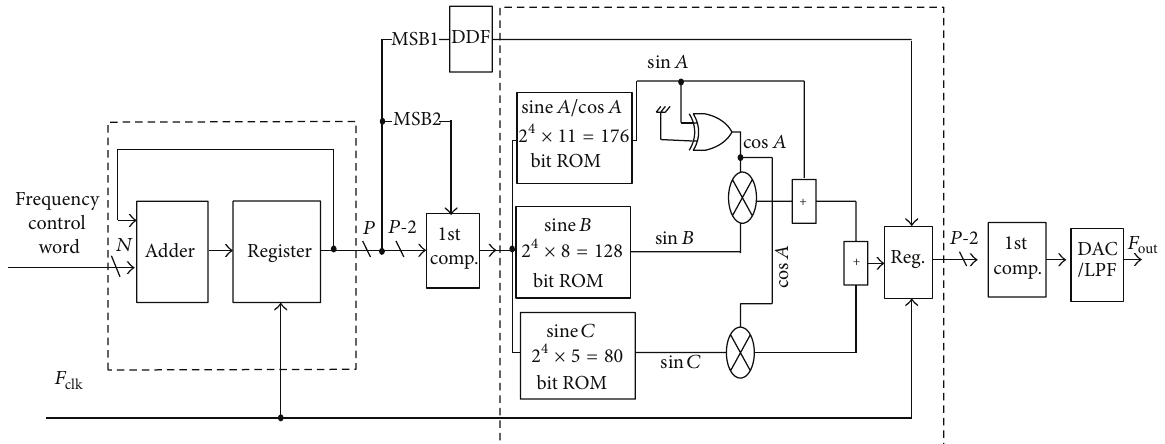
Figure 7: The block diagram of the final design of high-speed DDFS.